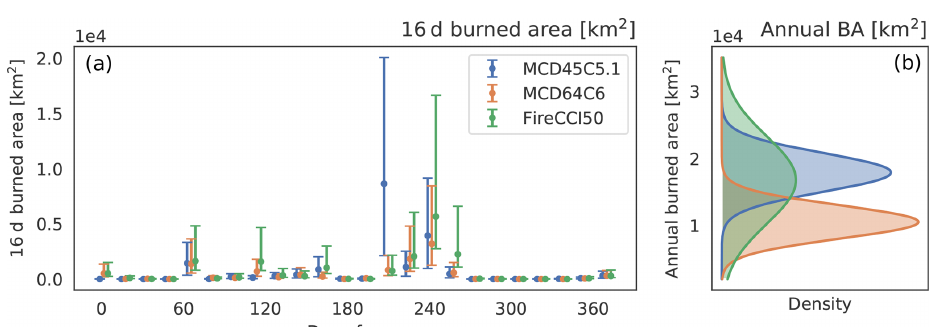
Figure 3. The 16d and annual uncertainties for a grid cell covering northern Australia. (a) The multiplicative error model provides unique uncertainties on each 16d observation for each product (95% confidence intervals shown). (b) To produce an annual uncertainty on the reported burned area, these are aggregated to produce an annual distribution which is then approximated as a normal